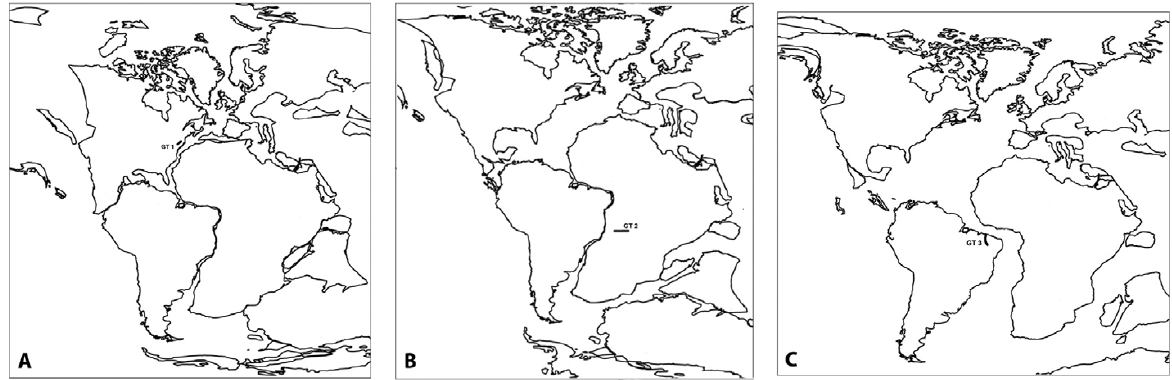
Fig. 12 - Generalized tracks. A , GT1 - Northeastern Newark (Upper Triassic); B , GT2 - Midwestern Gondwana (Upper Jurassic); C , GT3 - Itapecuru-Alcântara-Santana (Lower